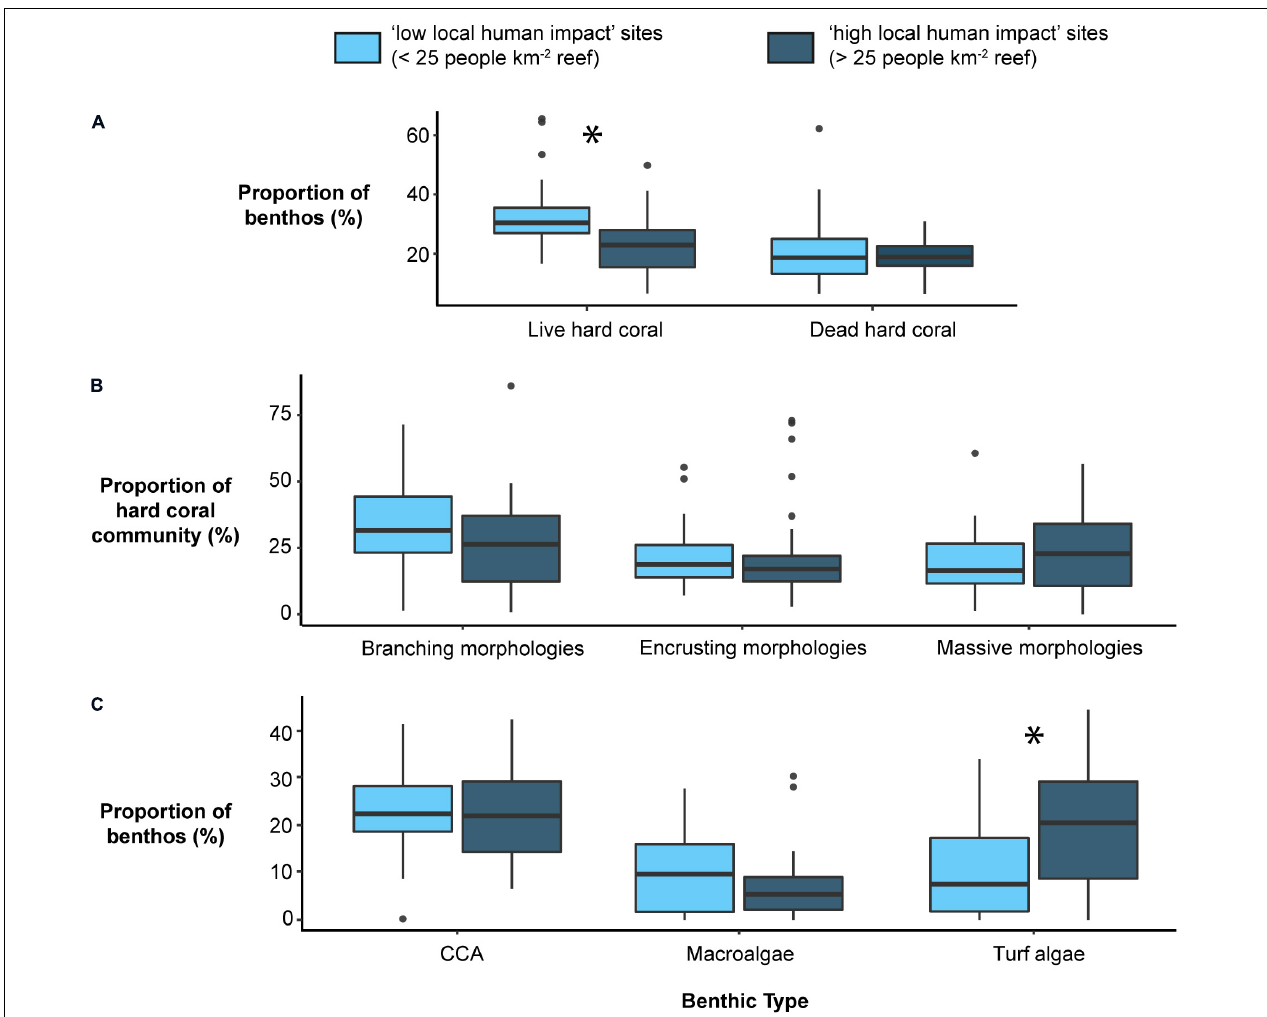
FIGURE 1 | Boxplots detailing (A) benthic cover (%) of substrate types (from left to right; live hard coral, dead hard coral), (B) the relative proportion (%) of the three most dominant morphologies in the live hard coral community (branching, encrusting, massive), and (C) benthic cover (%) of different algal groups (CCA, macroalgae, turf algae), at sites determined to have low or high local impacts. *Indicate significant differences ( p < 0.05) in cover of the respective benthic variable between local impact levels according to two-sample t -tests, or for turf algae according to linear mixed effect models incorporating bias_score as a random effect (see section “Model